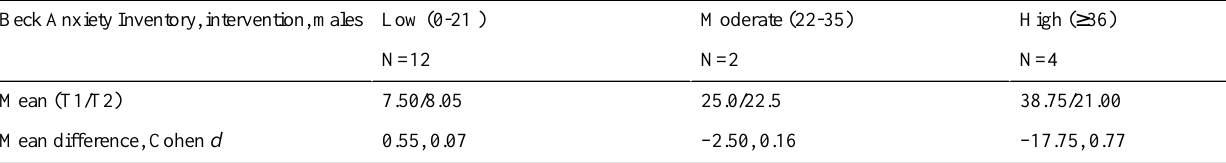
Table 12. Analysis of Beck Anxiety Inventory categories: male.